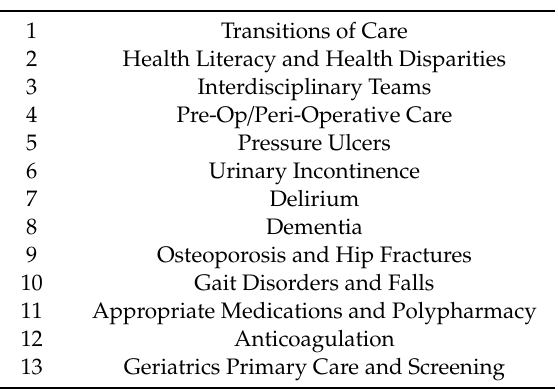
Table 1. Geriatrics Content